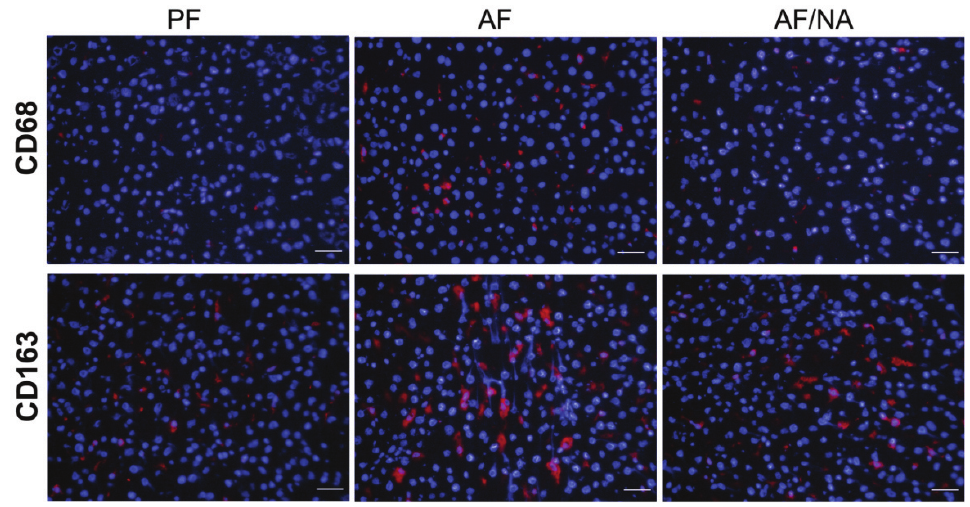
Figure 3. Immunofluorescence staining of hepatic CD68 and CD163 positive macrophages in rats fed alcohol with or without nicotinic acid supplementation for 8 weeks. Red color: CD68 + or CD163 + macrophages; blue color: 4',6-diamidino-2-phenylindole (DAPI) counterstaining of the nuclei. Scale bar: 20 (cid:3)m. PF: pair-fed; AF: alcohol-fed; AF/NA: alcohol-fed with nicotinic acid